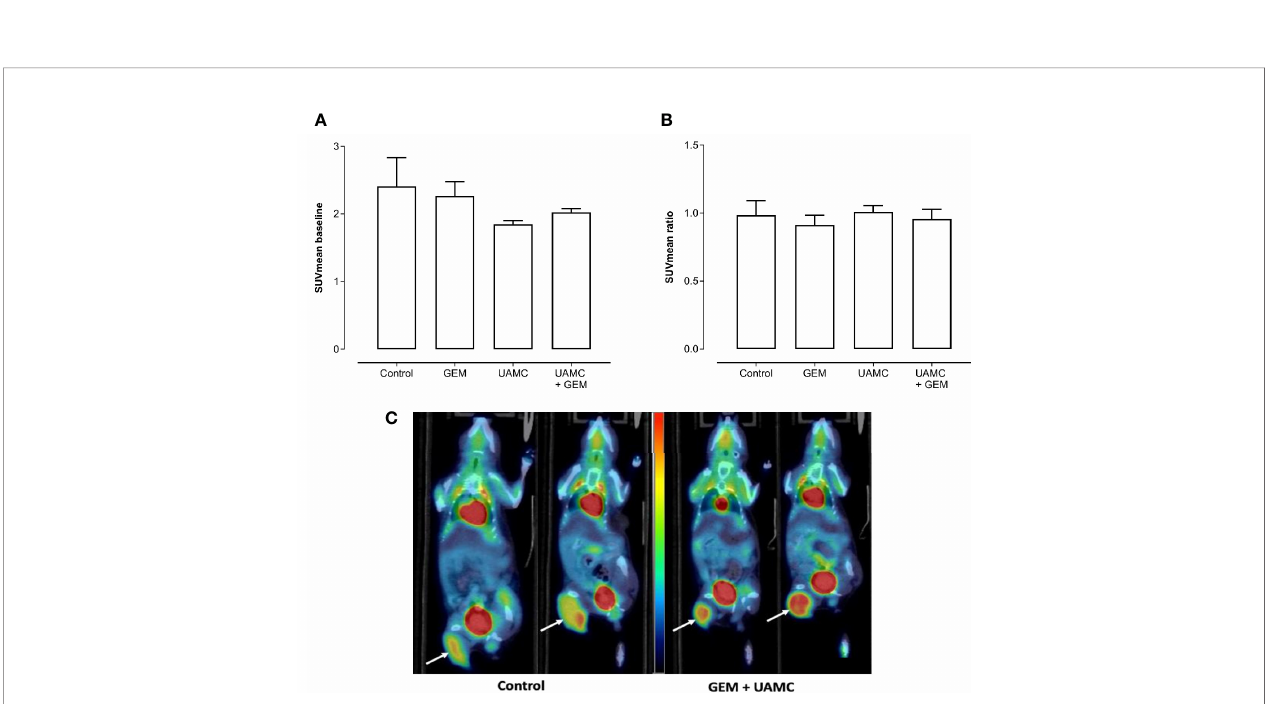
FIGURE 6 | PET/CT imaging of Panc02 tumors. C57/BL6 mice bearing Panc02 tumors were treated with vehicle (control), UAMC-2526 (UAMC), gemcitabine (GEM) or a combination of UAMC-2526 and gemcitabine. (A) Mice underwent a 18 F-FDG PET scan before the start of the treatment (baseline) and SUVmean was calculated. Number of animals in each group was between 4-7. Data were analyzed with factorial analysis of variance (ANOVA). No signi fi cance was found with factors GEM (p = 0.945) and UAMC (p = 0.108), interaction GEM by UAMC (p = 0.503). (B) Mice underwent a 18 F-FDG PET scan after 6-7 days of treatment. Thereafter, the SUVmean ratio versus baseline was calculated for the different treatment groups. Number of animals in each group was between 4-7. Data were analyzed with ANOVA. No signi fi cance was found with factors GEM (p = 0.445) and UAMC (p = 0.665), interaction GEM by UAMC (p = 0.899). (C) Representative 18 F-FDG PET/CT images at baseline and after 6-7 days of treatment. White arrows indicate the tumor. One mouse of the control group scanned at baseline (left) and after 6-7 days of treatment (right). One mouse of the combination group receiving gemcitabine and UAMC compound, also scanned at baseline (left) and after 6-7 days of treatment (right). All images were scaled to the same color scale (SUV scale from 0 –